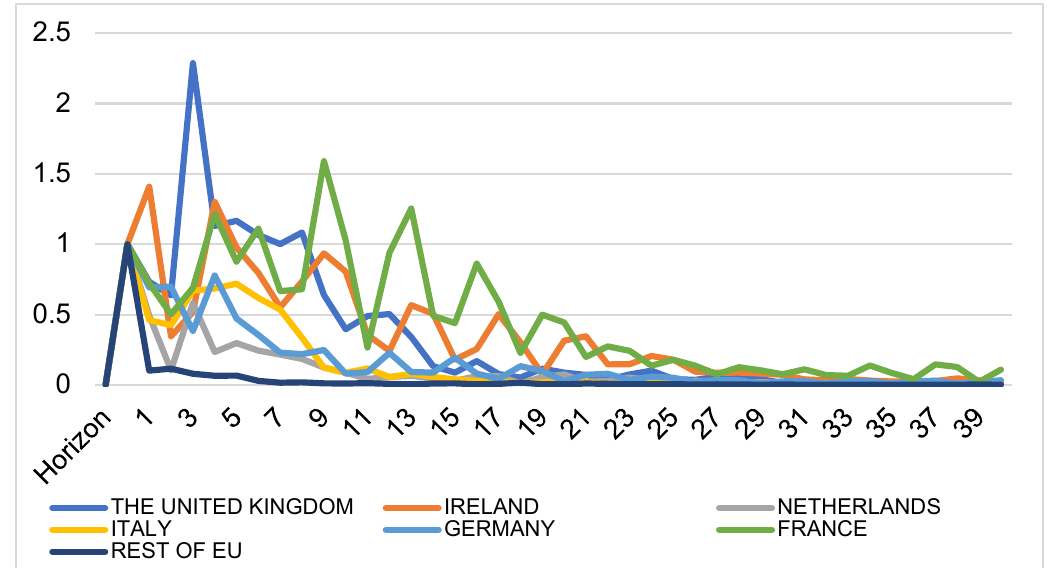
Figure A1. Persistence profile of the effect of system-wide shocks to the cointegrating relations of the intra-EU GVAR model.